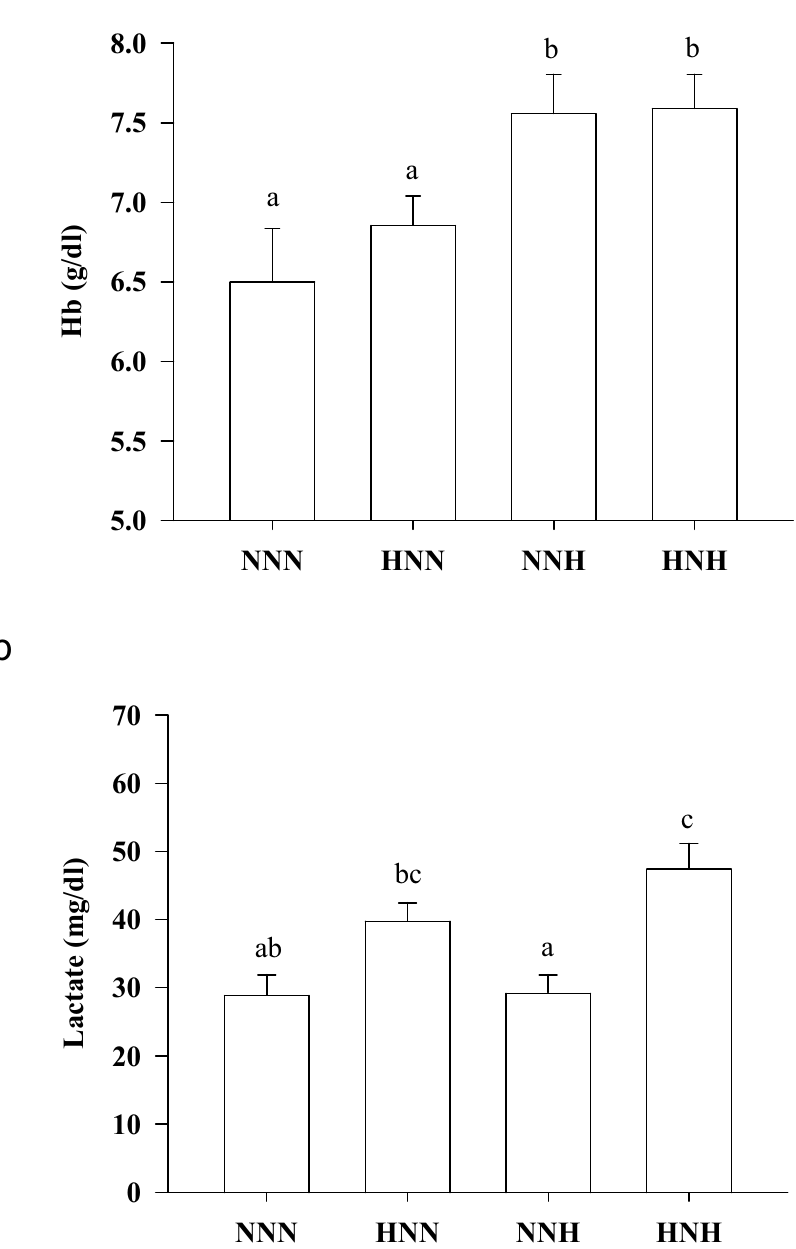
Figure 1. Blood haemoglobin ( a ) and lactate ( b ) levels of normoxic fish (NNN), early hypoxic fish (HNN), late hypoxic fish (NNH), and early and late hypoxic fish (HNH). Values are the mean ± SEM of 10–12 fish. Different letters indicate statistically significant differences among groups (Student Newman–Keuls test, P <